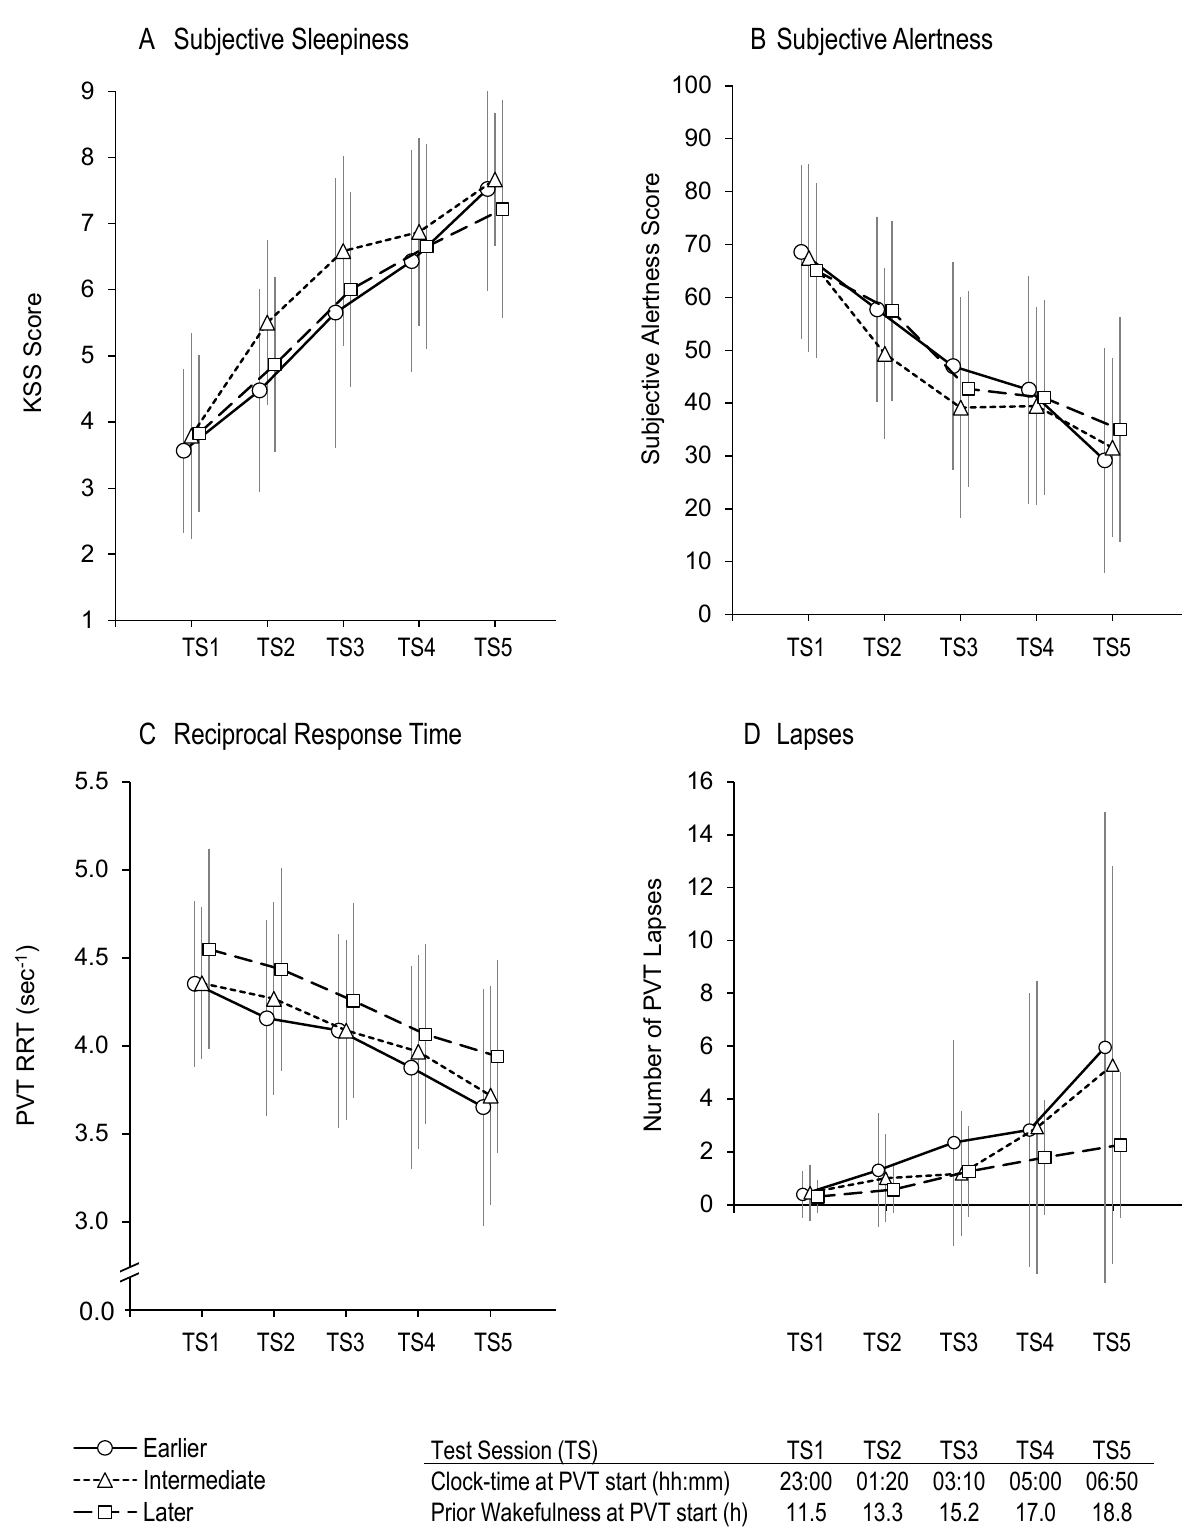
Figure 2. KSS (subjective sleepiness) scores ( A ), subjective alertness scores ( B ), PVT reciprocal response time ( C ), and number of PVT lapses ( D ) versus test session (TS) for earlier, intermediate, and later chronotypes. Mean scores at each test session have been offset to enhance interpretability. Error bars represent standard deviations from the means.